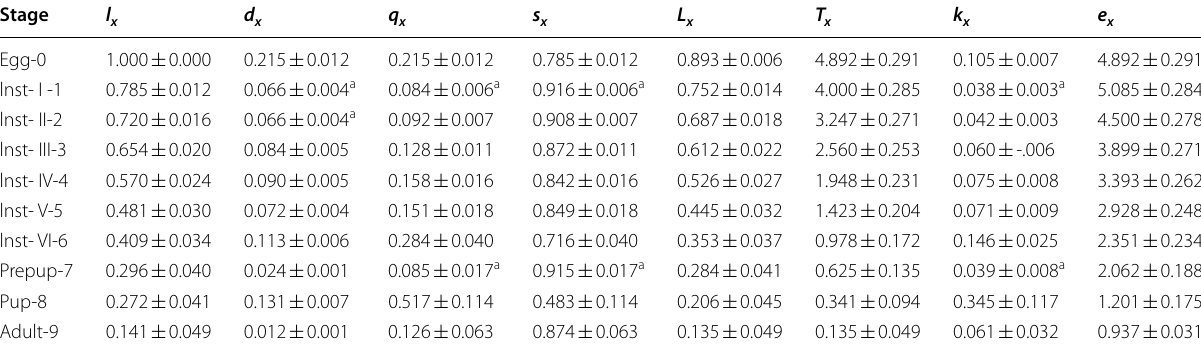
Table 4 Stage-specific pooled life table (Mean indicum ) variety: Amrit cultivated during 2019